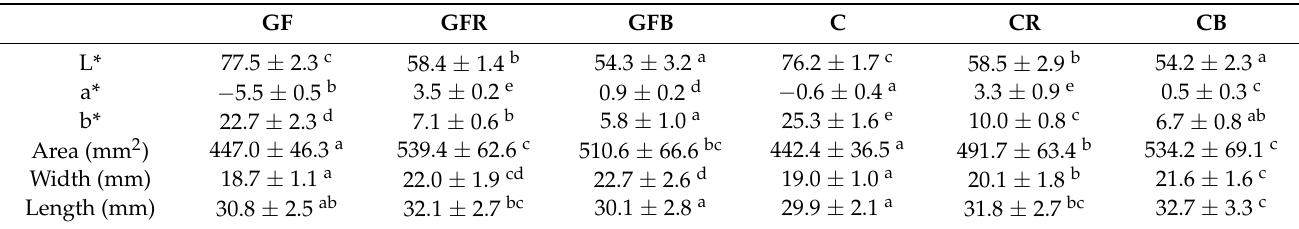
Table 2. Technological characterization of raw gnocchi.